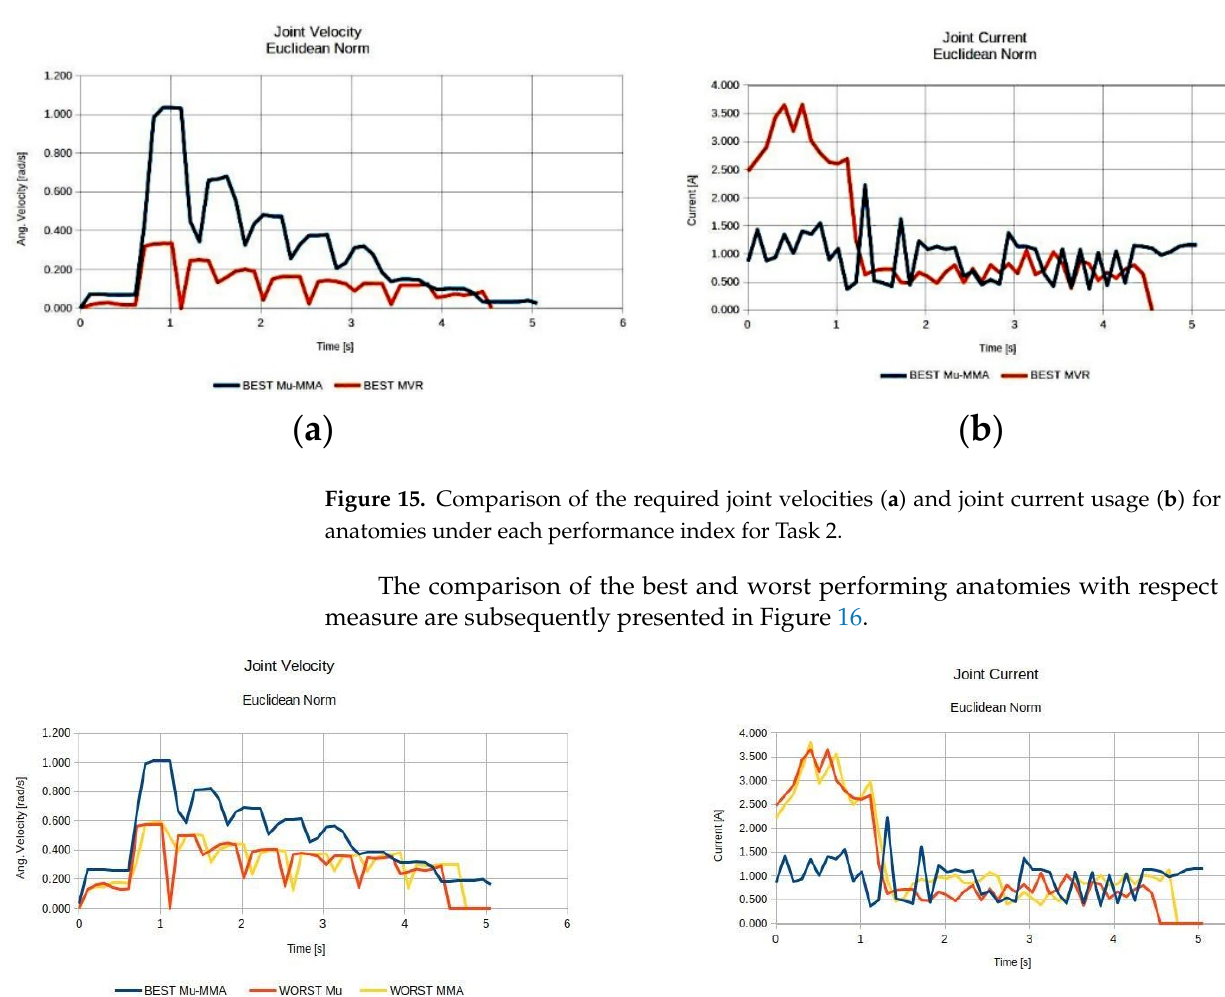
16 of 26 Figure 13. Optimal anatomy of the metamorphic manipulator derived under the MVR measure for Task 1. 3.2. Task 2: Linear Path (Direction Axis: − Z, Distance: 20 cm) The results of the application of the proposed method for a linear motion task of the end effector in the direction of the global z-axis with a distance of 20 cm for the considered kinematic and kinetostatic measures are presented in Figure 14. ( a ) ( c ) Figure 14. Derived mean index value for the selected performance indices under the available met- amorphic structure anatomies, for Task 2 (( a ) with respect to the Average Effective mass index, ( b ) with respect to the Average MMA index and ( c ) with respect to the average MVR index). With respect to the results of the previous task, it can be seen in Figure 14 that the best performing anatomy under the effective mass index (Figure 14a) and the best per- forming anatomy under the MMA index (Figure 14b) was anatomy no. 12, while the best performing anatomy under the MVR index (Figure 14c) was anatomy no. 44. The similar